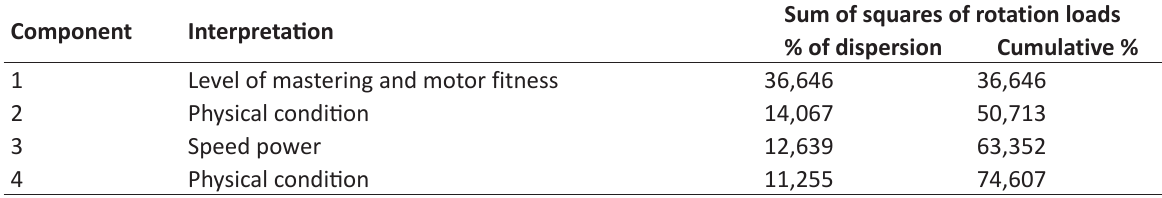
Table 5. Full explained dispersion Component